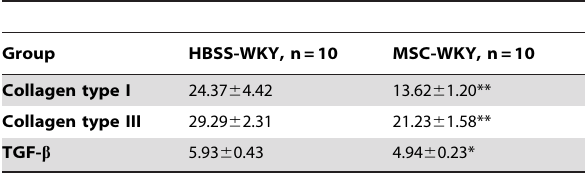
Table 4. Results of real-time RT-PCR for profibrogenic genes in renal cortex on day 13.